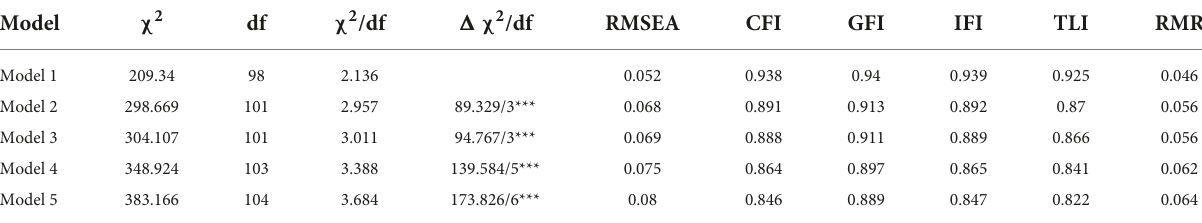
TABLE 6 Indicators of model